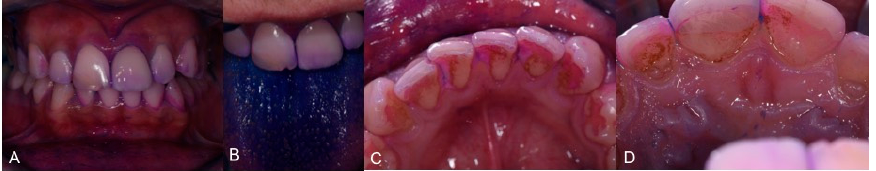
Figure 16. The TBM protocol is presented in several steps: ( A , B ). Plaque visualization; culus visualization that allows communication with patients. ( C , D ). Calculus visualization that allows communication with